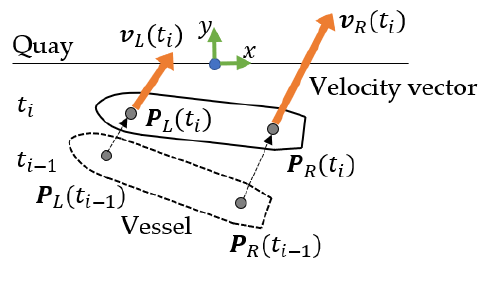
Figure 5. Velocity vectors for a linear